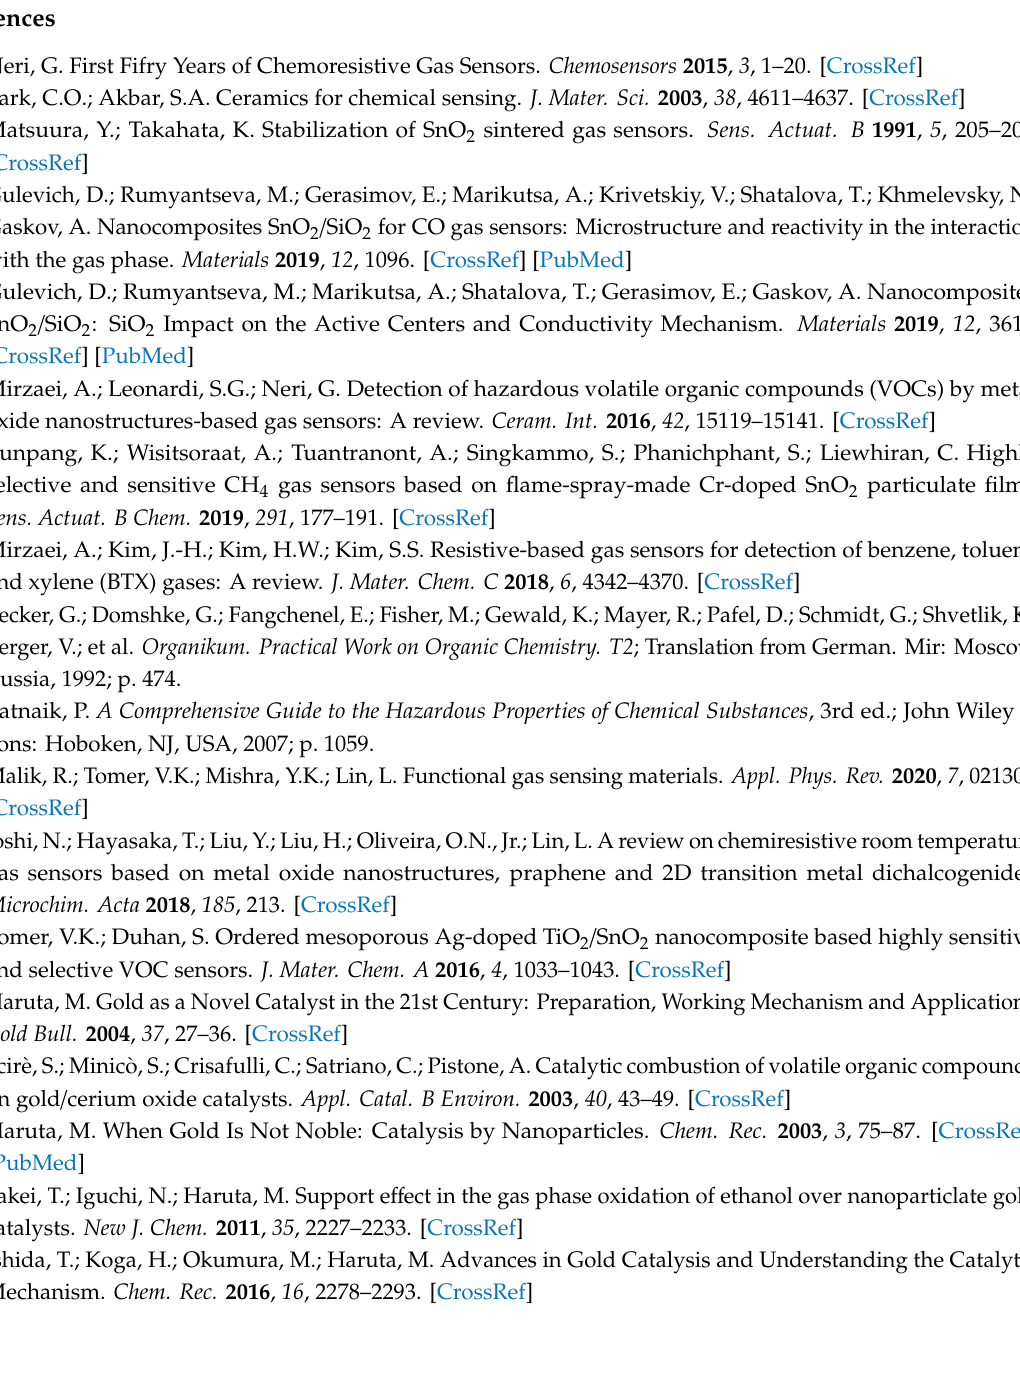
Figure S1: XRD patterns of nanocrystalline SnO 2 -300, SnO 2 -Au, SnO 2 / SiO 2 and SnO 2 / SiO 2